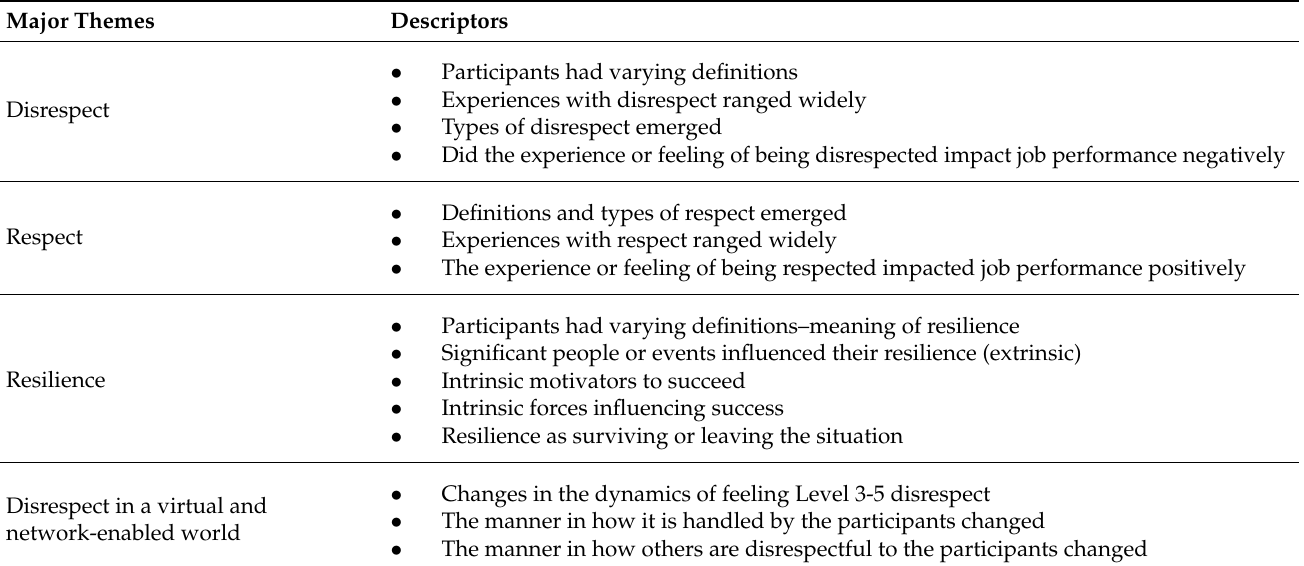
Table 2. Major Themes with Descriptors in Order of Significance to Research